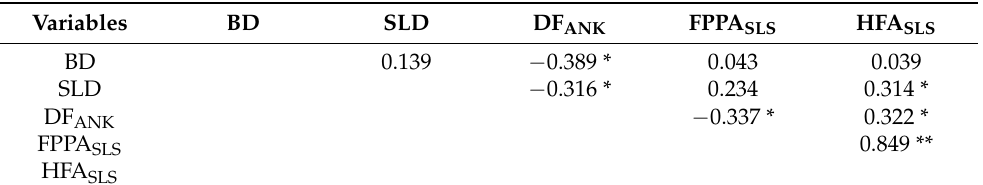
Table 2. Correlations of the participants’ core stability assessed during the bird-dog (BD) and